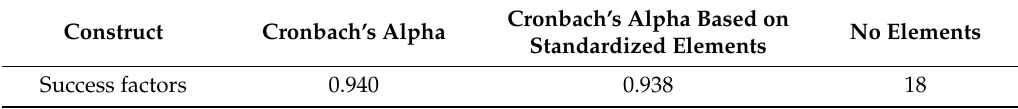
Table 2. Value of Cronbach’s alpha for the Likert-type question related to success